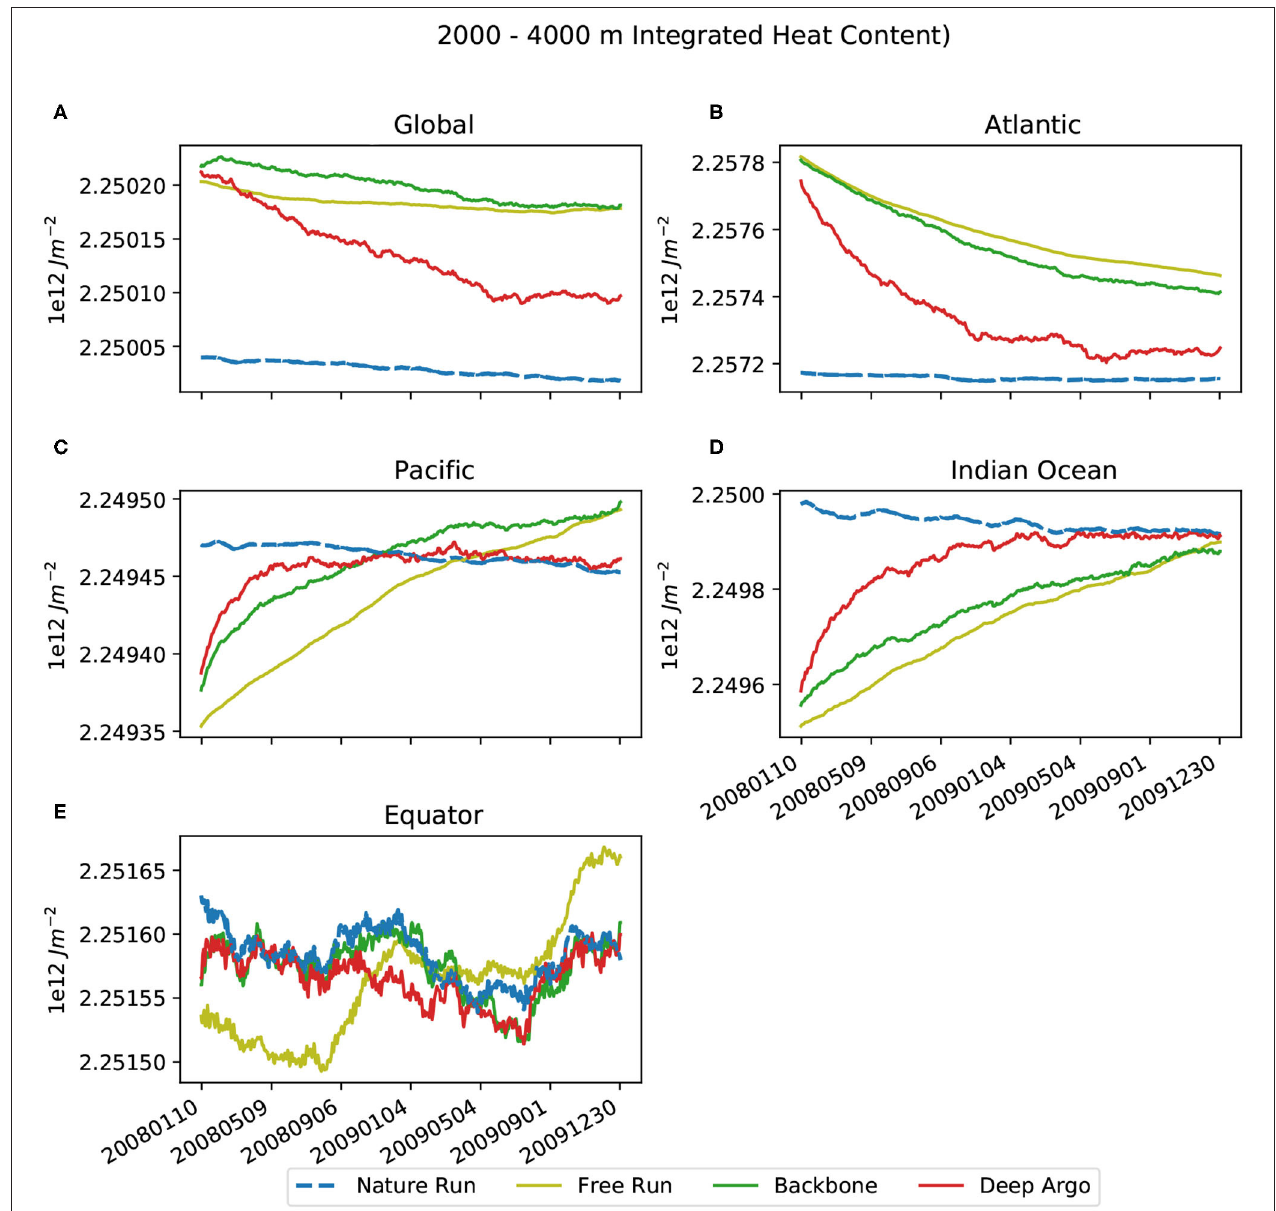
FIGURE 12 | The Heat Content between 2,000 and 4,000m for the Nature Run (dashed blue lines), Free Run (yellow), Backbone (green), and Deep Argo (red). The results were averaged over Global Ocean (A) , Atlantic (B) , Pacific (C) , Indian Ocean (D) , and Equator (E)